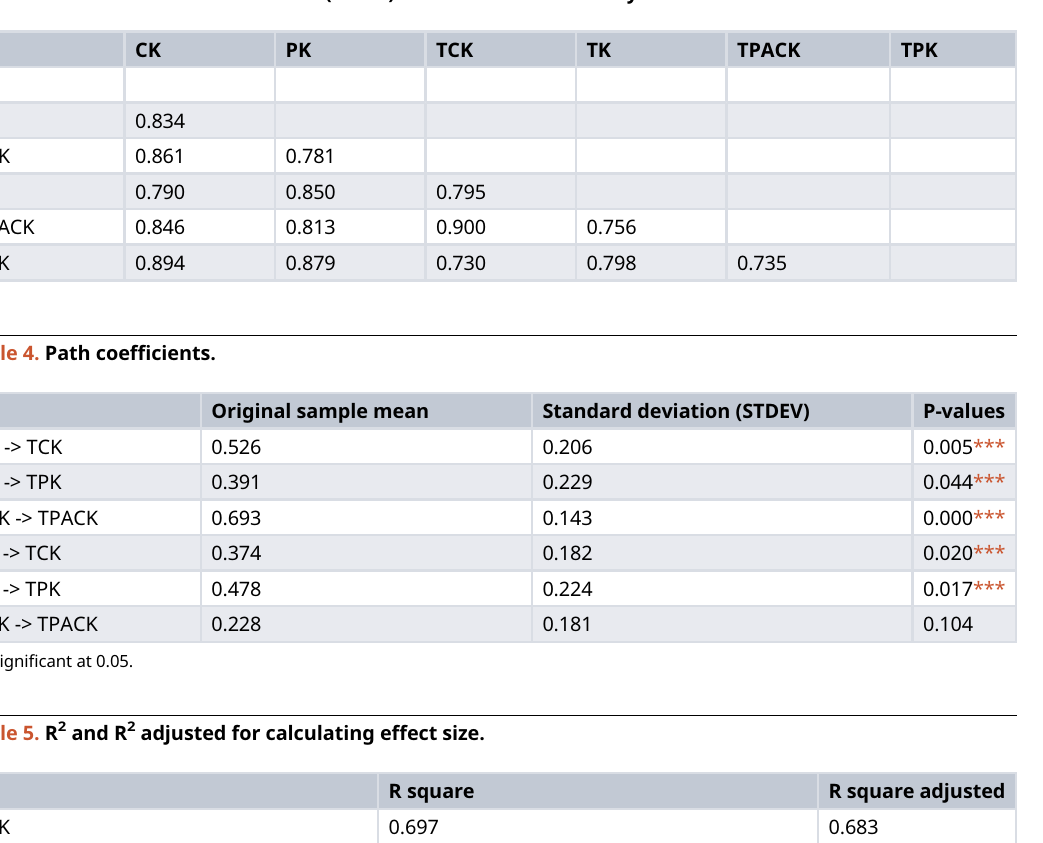
Table 3. Heterotrait-Monotrait Ratio (HTMT) for discriminant validity.